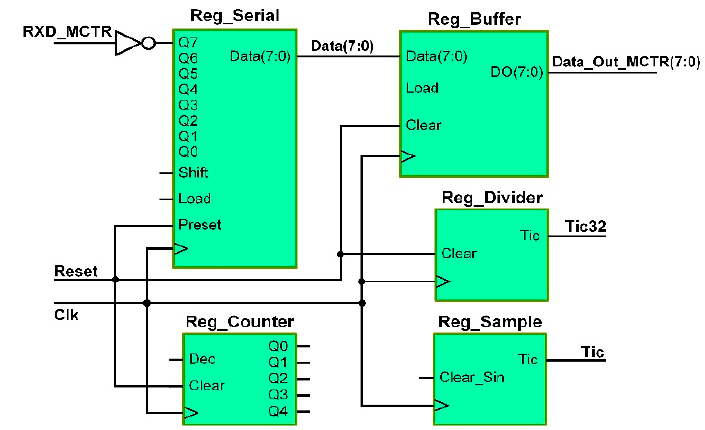
Figure 14. MCTR Entity Receiver FSMD Data Path.